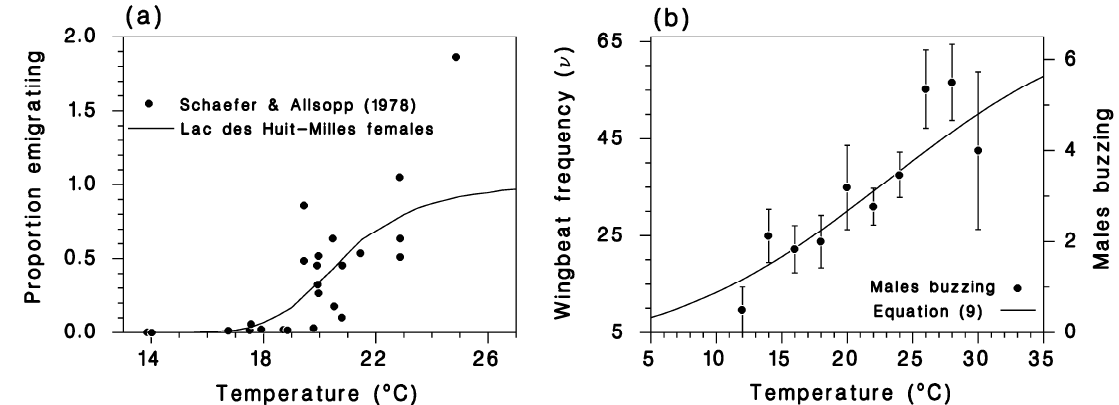
Figure 7. ( a ) Influence of temperature on proportion of females emigrating (circles: observations [39], line: prediction for females caught at Lac des Huit-Milles, 1989–1990); ( b ) observed temperatures and numbers of “buzzing” males (circles, from unpublished data of C.J. Sanders) and corresponding wingbeat frequency calculated with Equation (9) (solid line).